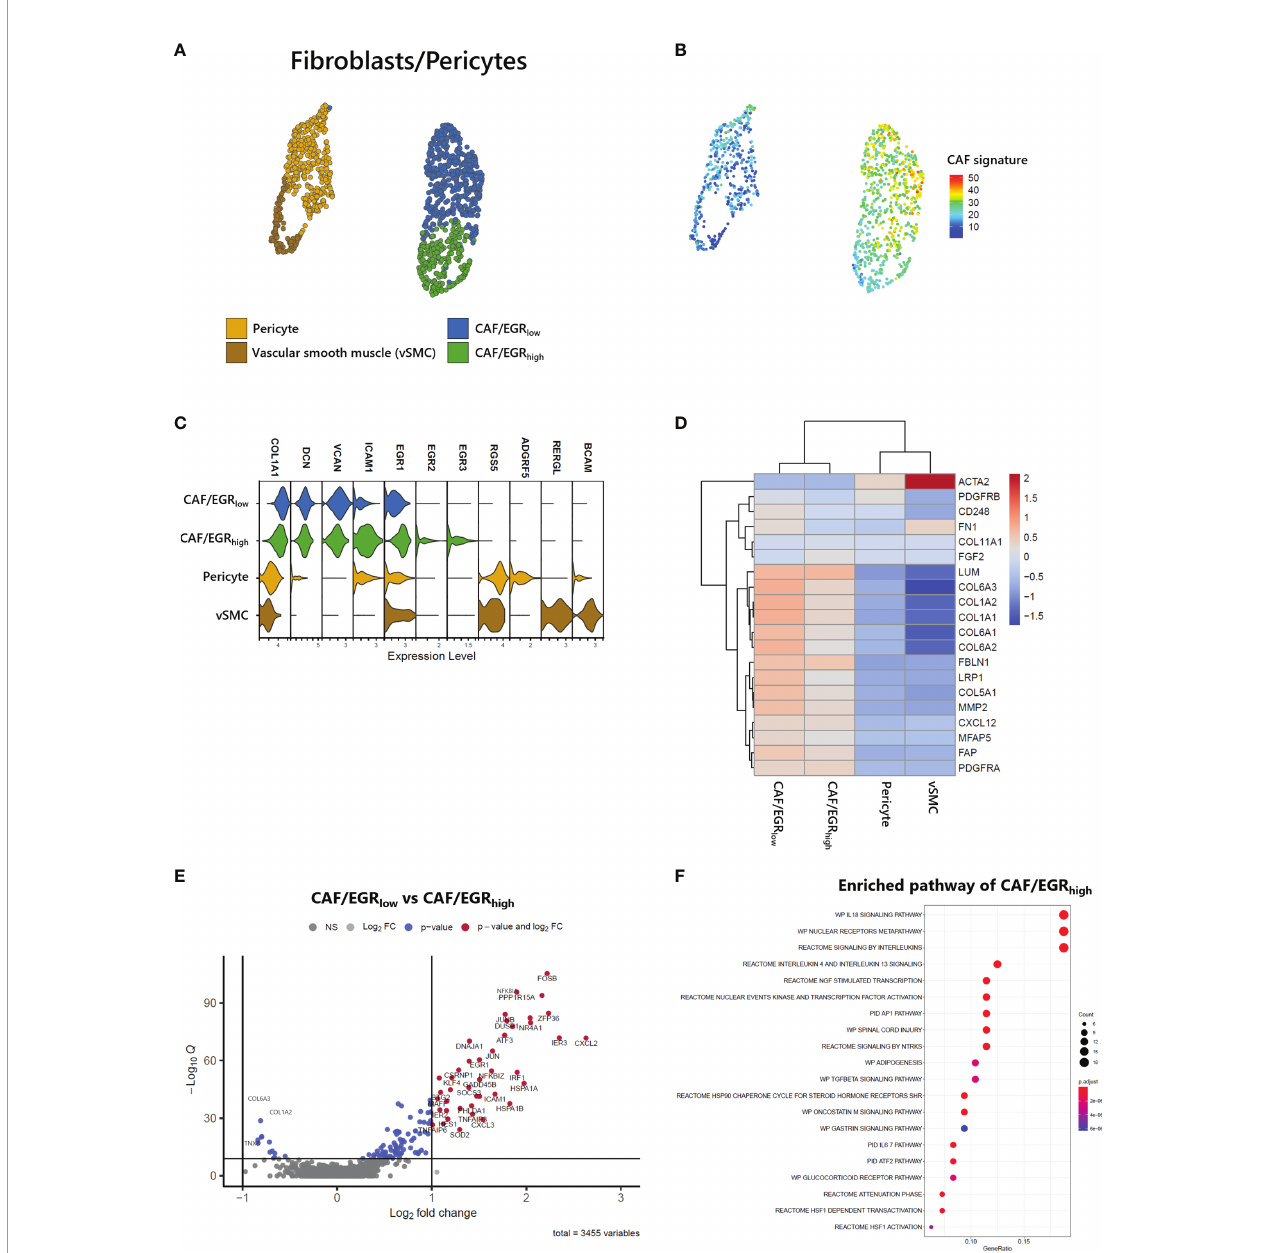
FIGURE 6 | Identi fi cation of CAFs in ATLL (A) Subtypes of stromal cells (B) CAF score calculated with the gene set suggested by Bagaev (17) within stromal cells (C) Cell-type markers of stromal cells (D) Scaled gene expression related to CAFs (E) Volcano plot showing DEGs of CAF subgroups (F) Enriched pathway of CAF/ EGR high